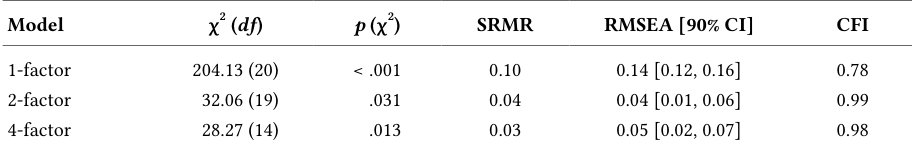
Goodness of Fit Indices for the Three Tested CFA Models of MAC-RF (N = 477)